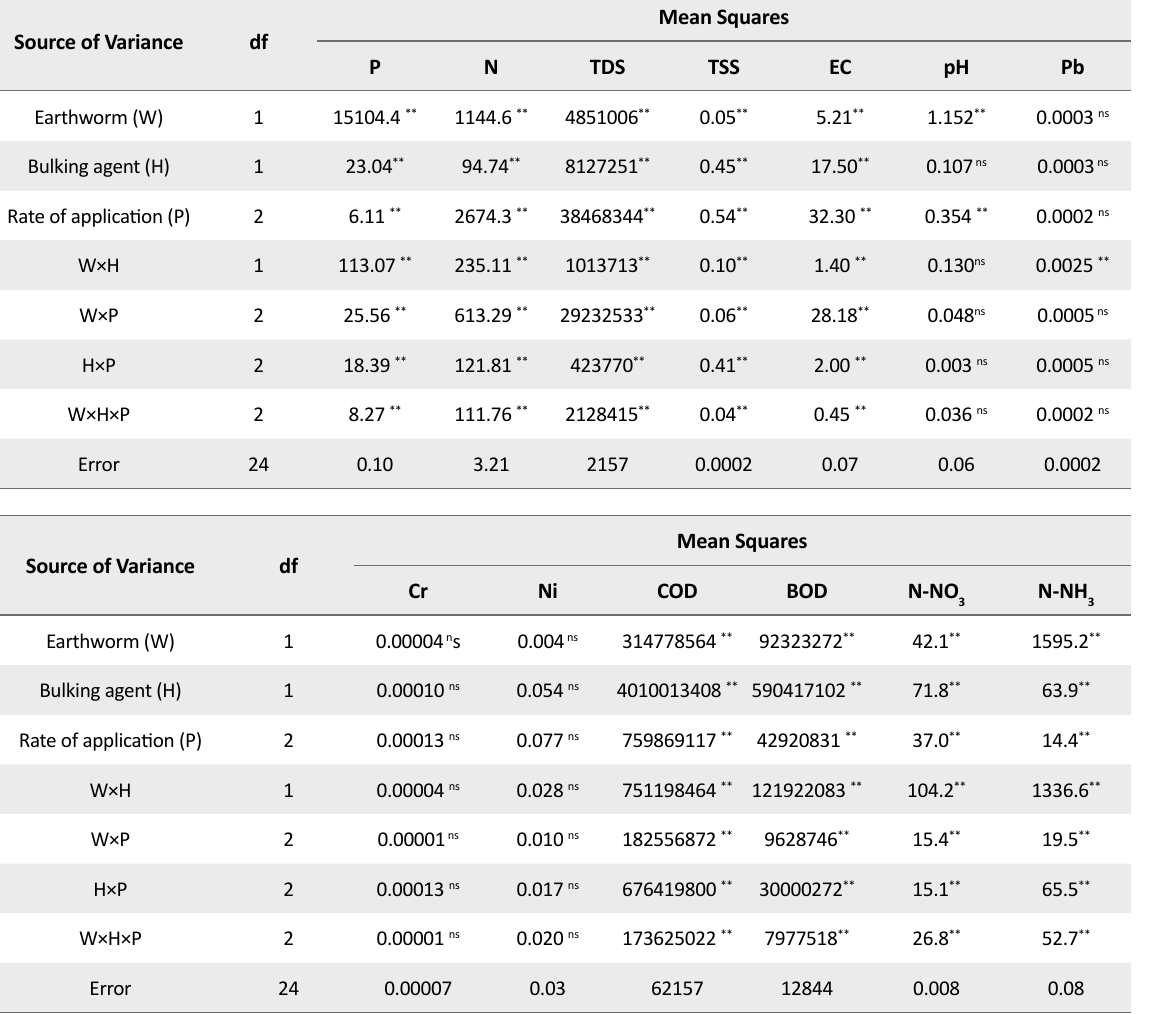
Table 2. Variance analysis of the effect of the treatments on the properties of wastewater Source of Variance df